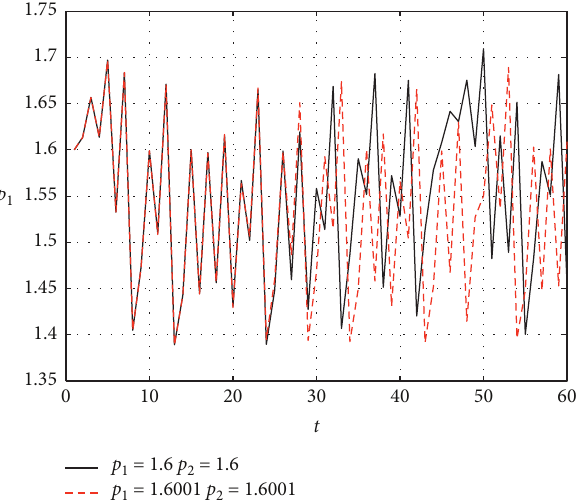
Figure 6: Price changing diagram ( p